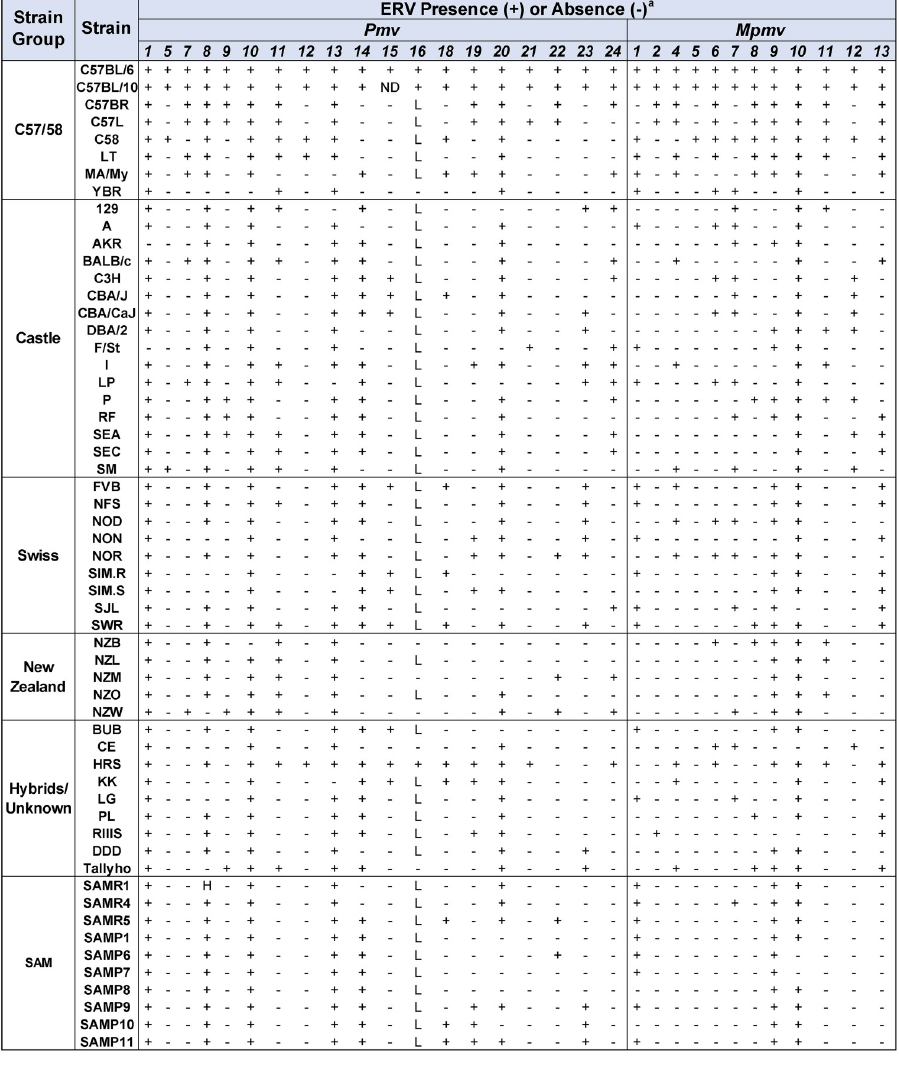
Fig 1. Classical mouse strains typed for 31 P-MLVs and grouped according to known breeding history. Substrains AKR/N and AKR/J, and substrains C57BL/6 and C57BL/10 carry identical ERVs, whereas the two CBA substrains differ for six ERVs likely due to genetic contamination [37]. The SIM.R Fv1 b congenic differs from its SIM progenitor in the presence of 6 ERVs found in the Fv1 b donor strain, three of which are linked to Fv1 . a +, presence; -, absence; L, solo LTR; H, heterozygous; ND, not